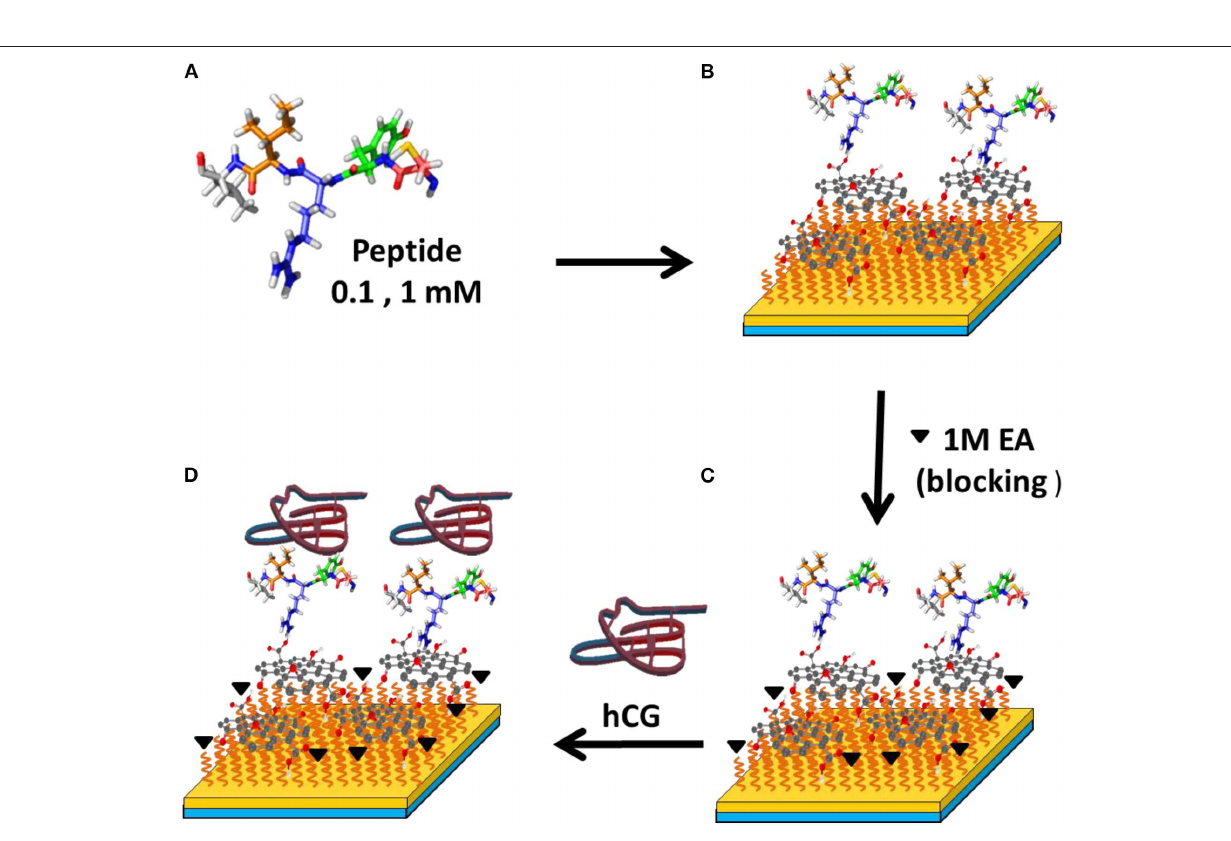
addition, BSA was covalently immobilized to block carboxyl-GO sheets in areas that are not coated with anti–PAPP-A2